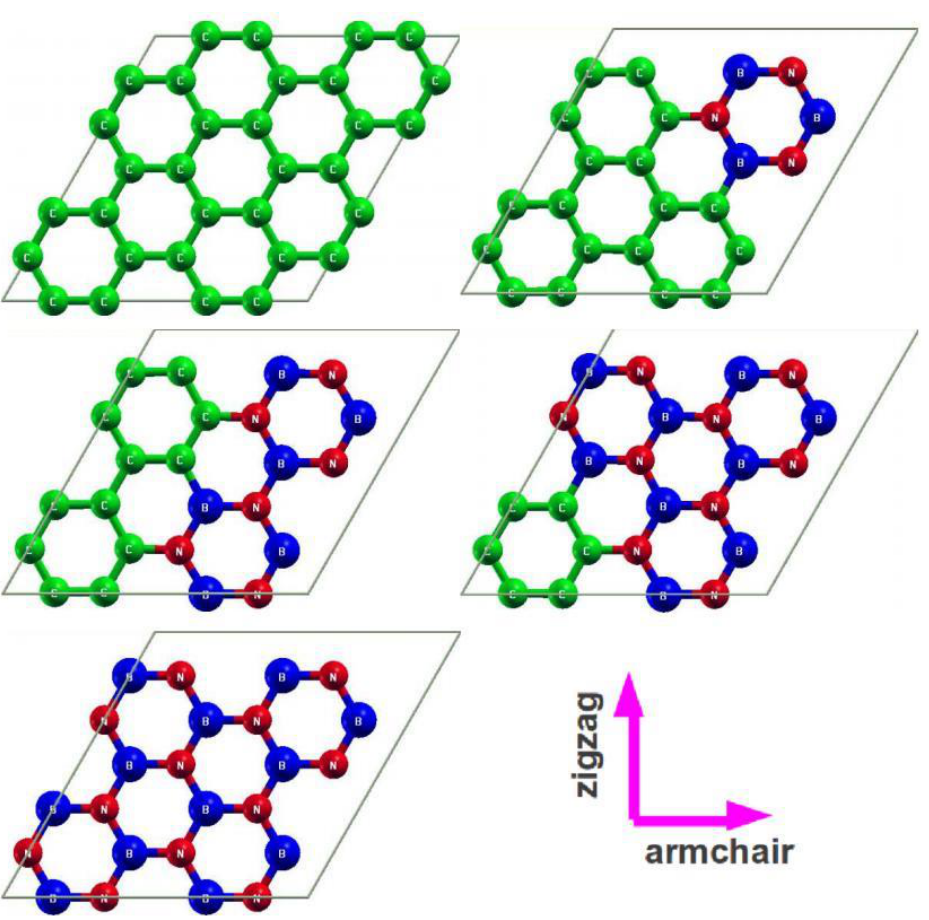
Figure 2. Atomic super cell (24 atoms) of five g -BNC configurations in the undeformed reference configurations, corresponding to g -BN concentration of 0% (graphene), 25%, 50%, 75%, and 100% ( g -BN).